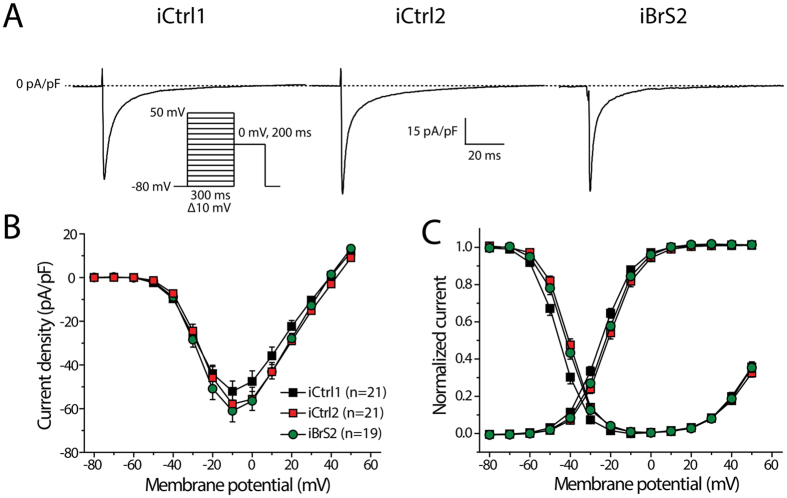
L-type calcium current (ICa,L) in hiPSC-CMs from iCtrl1, iCtrl2 and iBrS2.(A) Typical traces of ICa,L measured at a test potential of 0 mV. Inset shows the used voltage clamp protocol. (B) I-V relationships of ICa,L. (C) Voltage dependence of activation and inactivation.